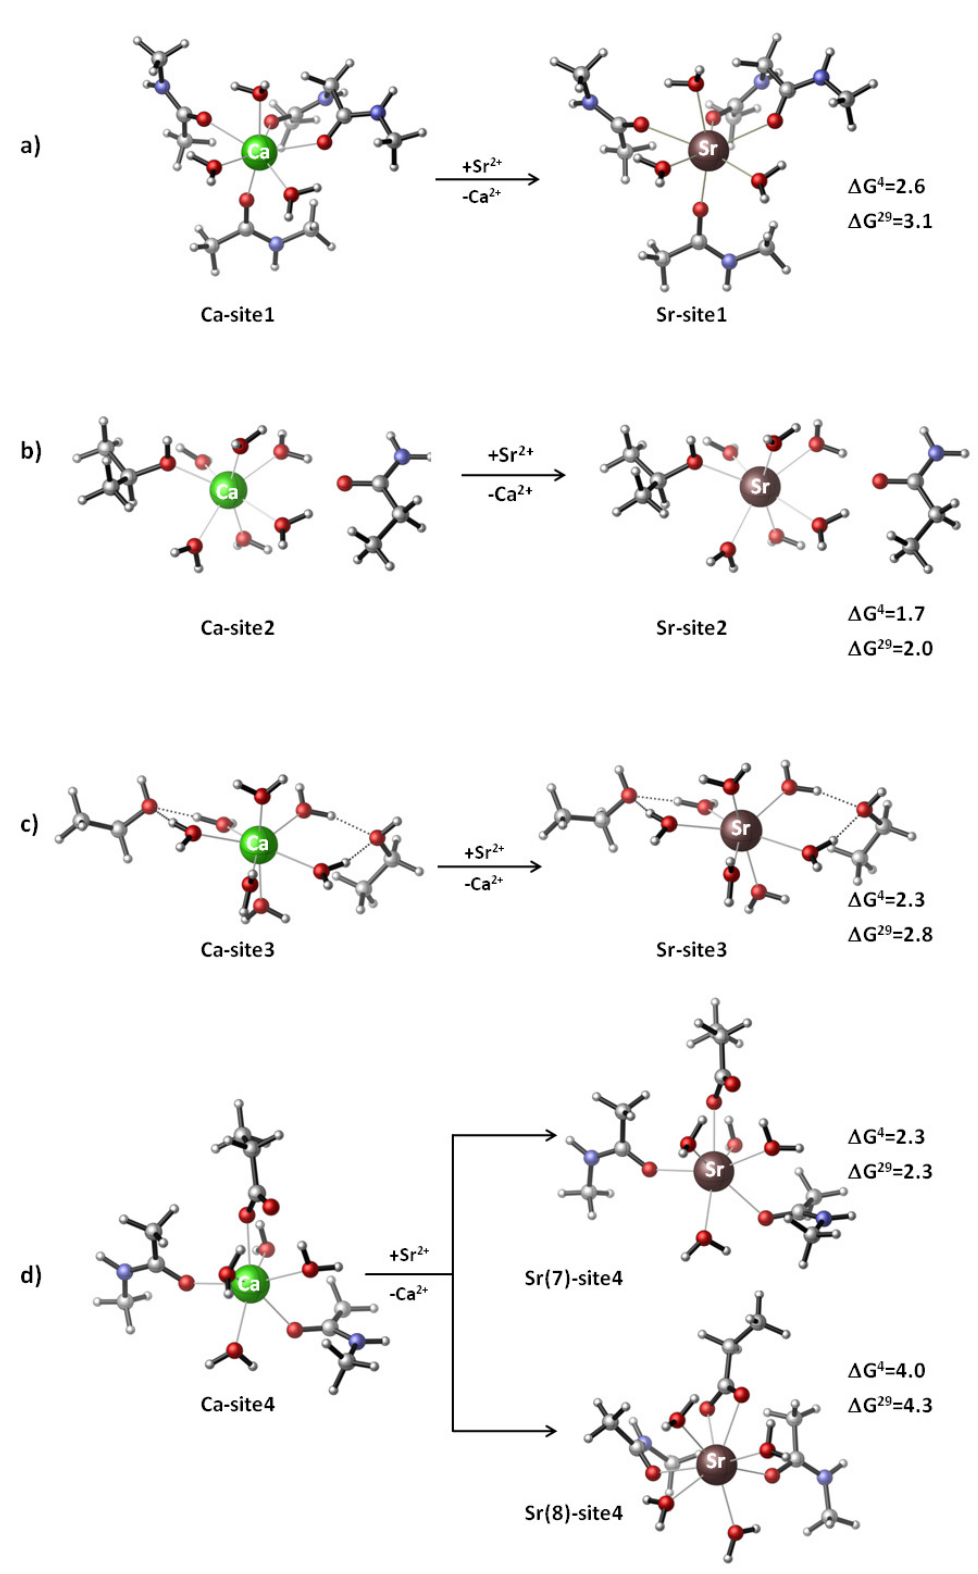
Figure 1. Fully optimized Ca 2+ and Sr 2+ -loaded metal-binding sites of CaSR: ( a ) Site 1, ( b ) Site 2, ( c ) Site 3 and ( d ) Site 4 (drawn by CYLview visualization software [23]) along with the Gibbs free energies (in kcal/mol) of the Ca 2+ → Sr 2+ substitution.